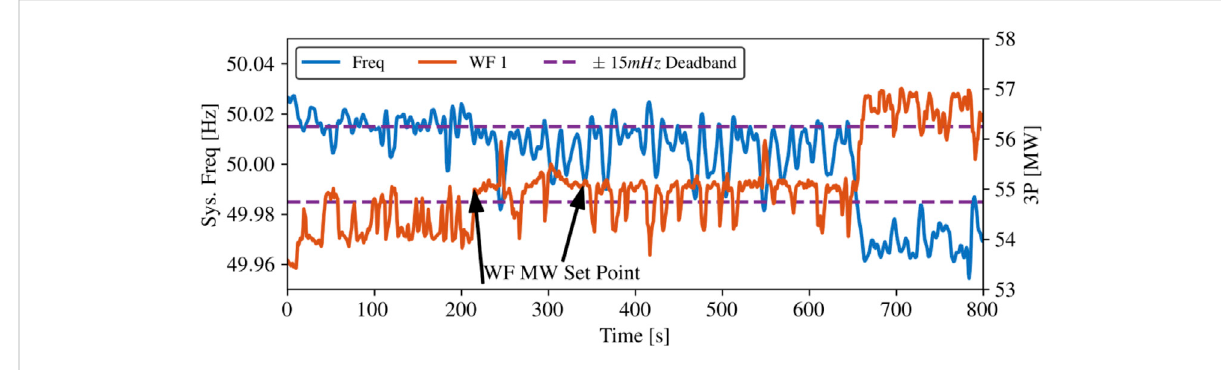
FIGURE 14 Wind Farm power response and interaction with reduced + − 15 mHz